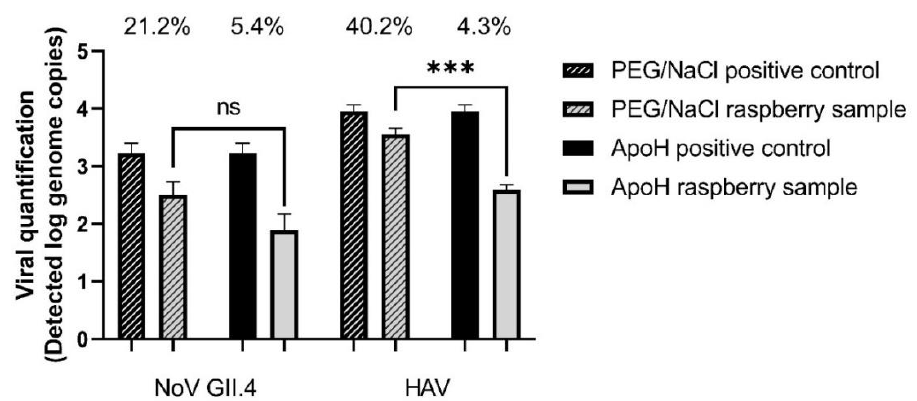
Figure 2. Simultaneous detection of HAV and NoV GII.4 on fresh raspberries using PEG/NaCl or ApoH beads to concentrate the viruses. Initial viral load at 1 × 10 5 genome copies/sample and NoV GII.4. Three asterisks indicate statistically significant differences ( p ≤ 0.001), and ns indicates no statistically significant differences between the viral recuperation of the ApoH method and the ISO method based on the unpaired, two tailed t -test. Statistical significance is based on the unpaired, two-tailed t -test.